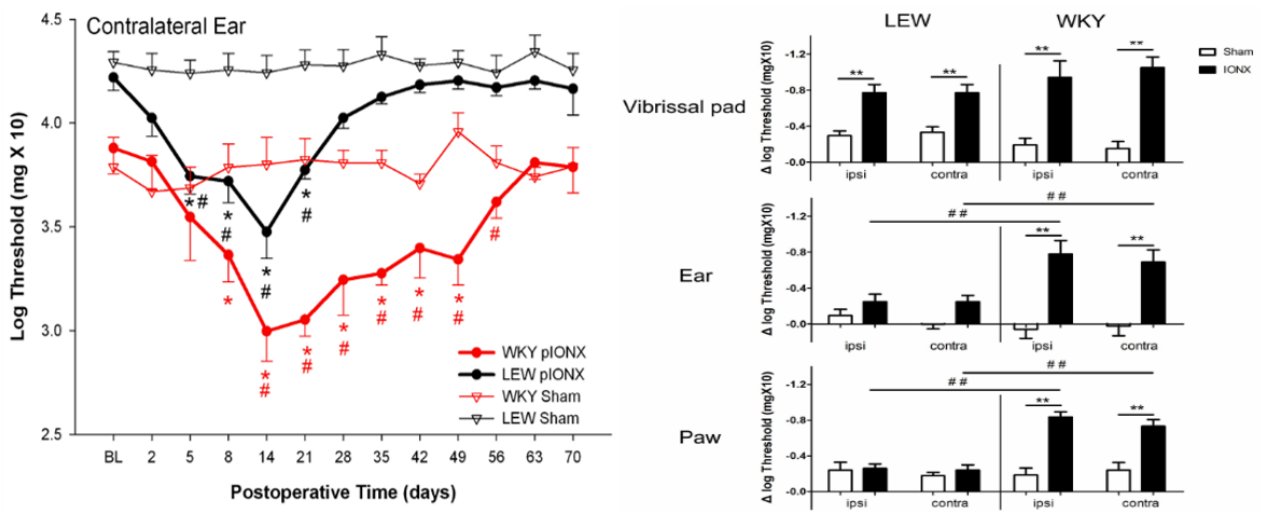
Figure 4. Infraorbital nerve injury in the rat induces hypersensitivity that spreads extraterritorially and is genetically dependent. In adult male WKY and LEW rats housed under similar environmental conditions, head withdrawal thresholds to mechanical stimulation of the facial vibrissal pads, ears and hindpaws were assessed bilaterally with von Frey monofilaments before (baseline [BL]) and after receiving unilateral transection (IONX) of the medial branch of the infraorbital nerve (that supplies medial aspect of upper lip, vibrissal pad and anterior teeth) or sham operation ( n = 10/group). On the left is an example of the time course of the effect of the partial IONX (in comparison to sham) in inducing extraterritorial spread of sensitivity (ETSS) as reflected in a significant decrease in the withdrawal threshold to mechanical stimulation of the contralateral ear (2-way ANOVA, p < 0.05). This reflection of IONX-induced nociceptive behaviour occurred in both strains but was significantly greater and longer lasting in the WKY rats. Additional evidence of ETSS is illustrated on the right where WKY rats showed, at 3–5 weeks post-IONX, significantly (2-way ANOVA, p < 0.05) decreased mechanical withdrawal thresholds not only in the contralateral ear but also in in the lateral part of the partially denervated ipsilateral vibrissal pad, and ear and hindpaw. LEW rats also displayed significant ETSS but only for the vibrissal pad; their levels of mechanical hypersensitivity in the ear and hindpaw were significantly lower ( t -test, p < 0.05) than those in WKY rats. They also showed significantly lower levels of heat hypersensitivity in these sites that were tested by applying noxious infrared laser heat stimuli (200 msec, 18–25 Amp, 2 mm in diameter diode) to these sites (not shown). * p < 0.05 comparison to baseline, ** p < 0.05 and # p < 0.05, ## p < 0.05 comparison between groups. Based on data from Wang et al.